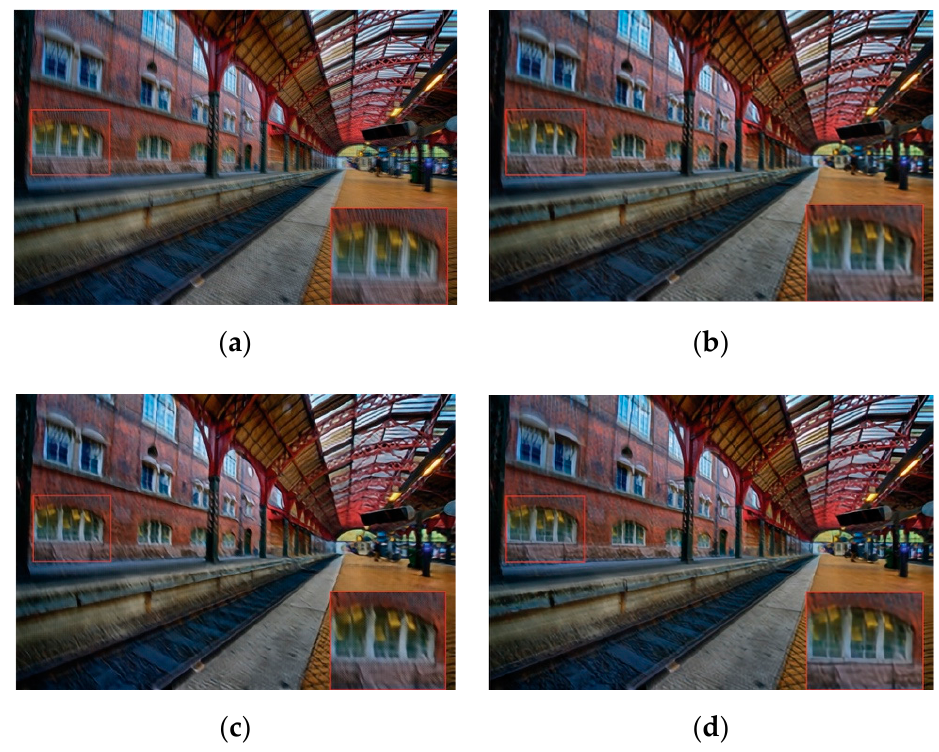
Figure 1. An example result of the presented decoupling induction and multi-order attention gating model for joint deblurring and 4× super-resolution. The details in the recovered image of our proposed method ( d ) are much clearer than those of RCAN [11] ( b ) and SCGAN [6] ( c ); the LR and blurred image is shown ( a